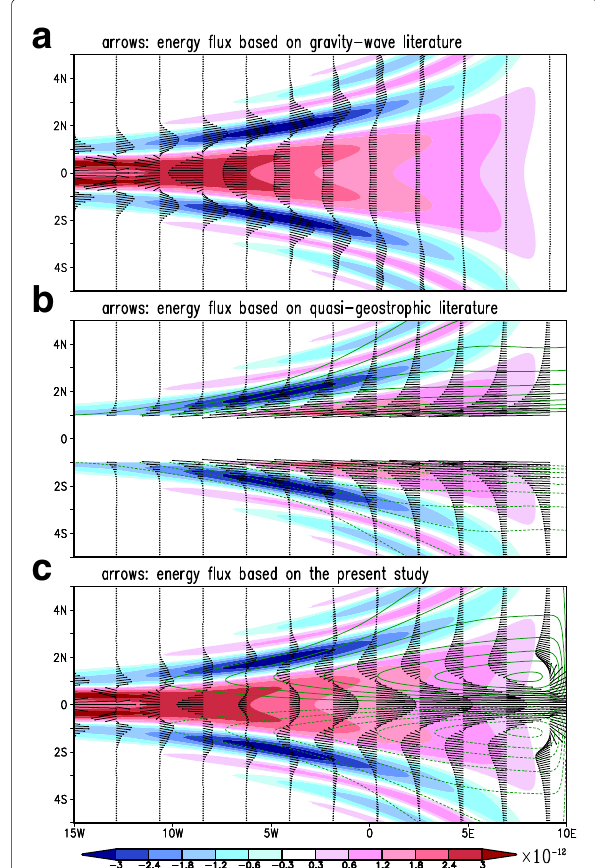
Fig. 7 Same as Fig. 6 except that this is an enlarged view of the eastern equatorial region of the model